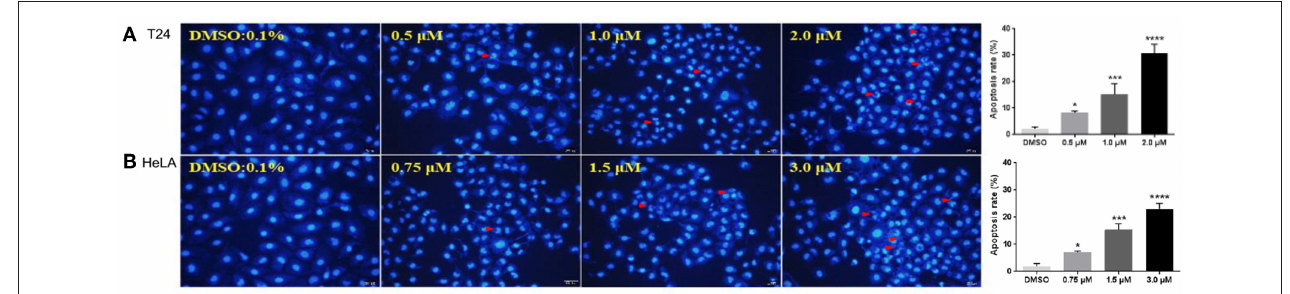
FIGURE 3 | Fluorescent images of Hoechst 33258 staining showing compound 12g induced cell death with 0.1% DMSO vehicle as the control. Cells were examined under a fluorescence microscope. The arrows indicated the formation of apoptotic bodies with condensed chromatin or fragmented chromatin. (A) Treatment of T24 cells with 12g for 24h. (B) Treatment of HeLA cells with 12g for 24h. The apoptosis rates of T24 and HeLA cells with treatment of 12g were quantify and analyzed by One-way ANOVA ( n = 3 in each treatment). * P < 0.05, *** P < 0.001, and **** P < 0.0001 compared with the vehicle (0.1% DMSO). The statistical data are presented as mean ± S.D. Scale bar = 50 µ m.